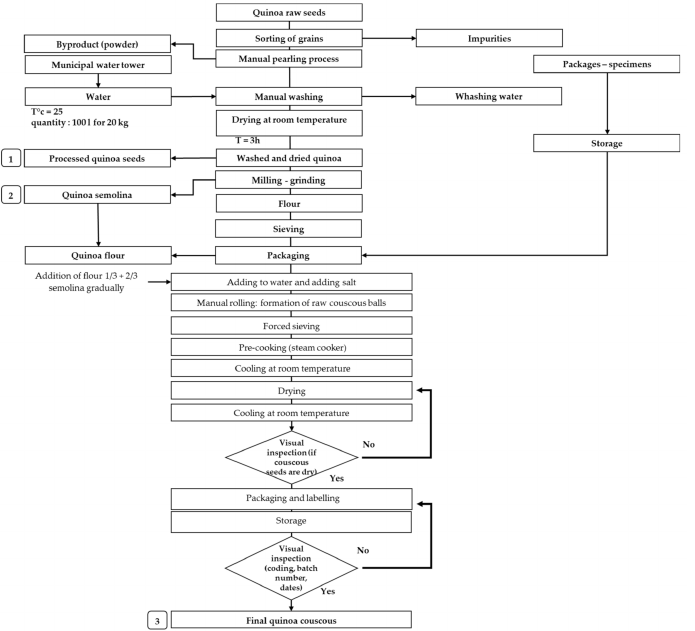
Figure 1. Processing diagram for quinoa based products adapted from the “3rd Millennium”